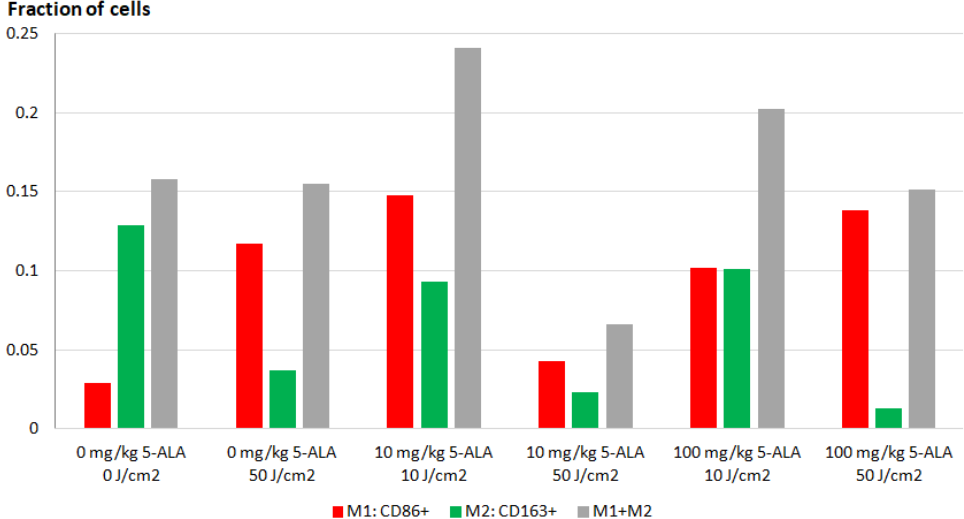
Figure 8. Fraction of M1 and M2 macrophages in the tumor space, counted per total number of cells.